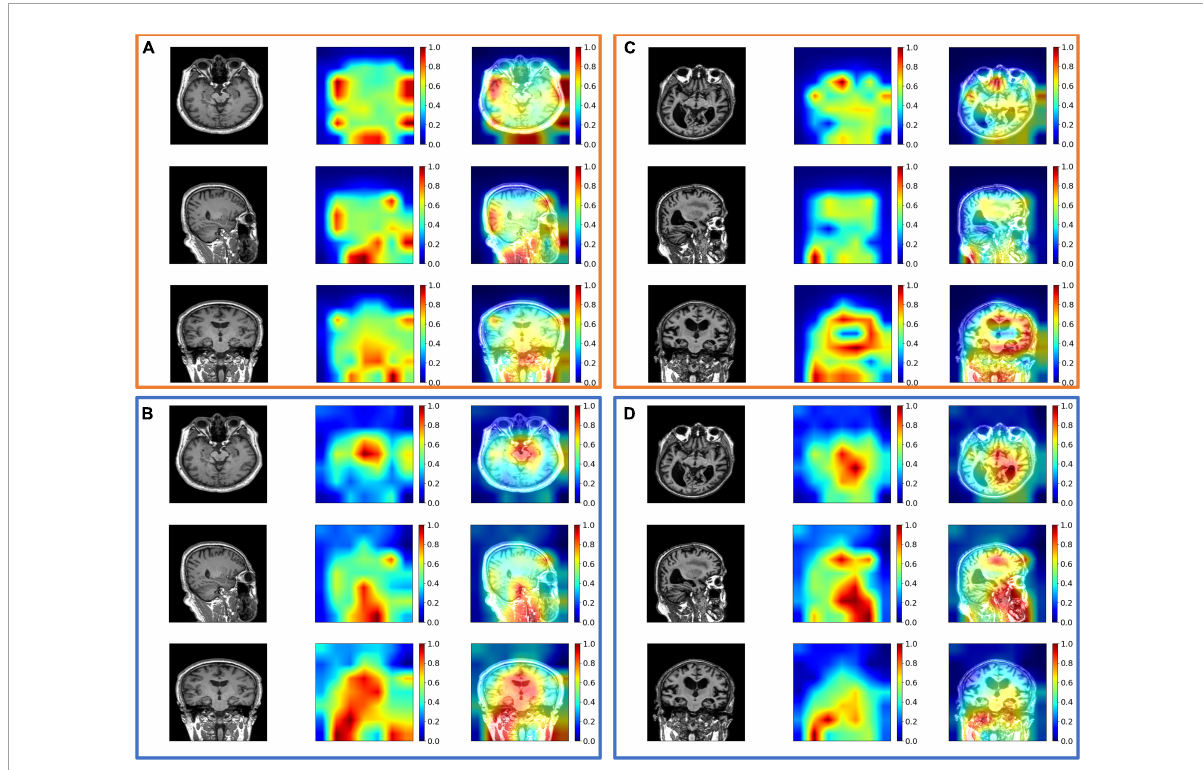
FIGURE4 The exemplary attention maps (A) with spatial-attention mechanism (SAM) and temporal-attention mechanism (TAM) and (B) without SAM and TAM on diabetes mellitus (DM) datasets; (C) with SAM and TAM, and (D) without SAM and TAM on Alzheimer’s Disease Neuroimaging Initiative (ADNI) datasets. The views from the top row to the bottom row are axial, coronal, and sagittal views. The corresponding images from left to right are the original image, attention map, and image overlayed with the attention map. The value of the attention map from zero to one is assigned blue to red colors. Noted that attention maps without SAM and TAM may suffer from inaccurate feature extraction, such as high attention values close to 1 out of the head in panels (A,C) .